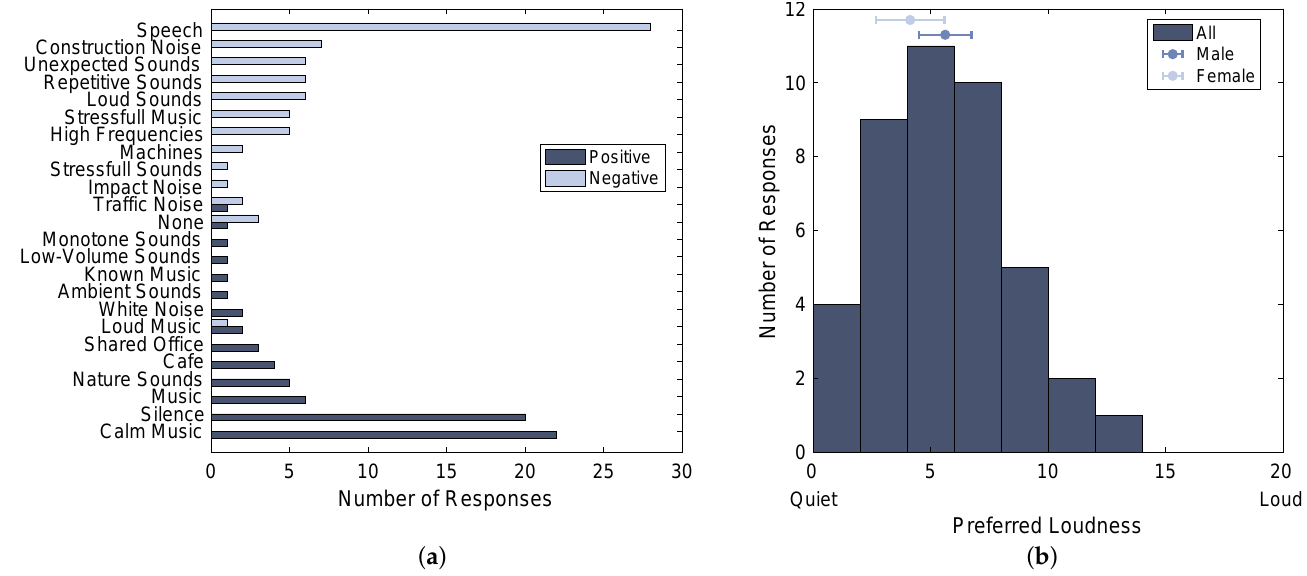
Figure 5. Participants’ responses of ( a ) positive and negative acoustic environments as well as ( b ) loudness preference for concentrated working. Error bars indicate mean and 95% confidence intervals for male and female